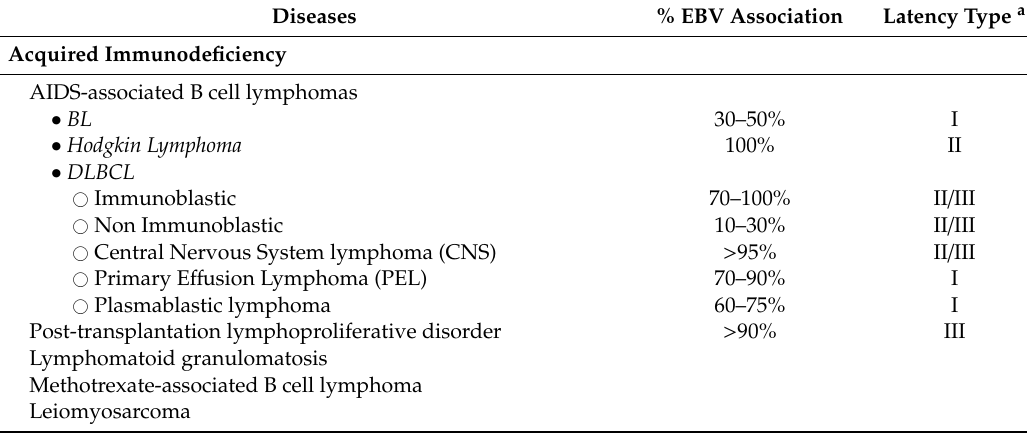
Table 2. EBV-associated malignancies in immunodeficient hosts and corresponding EBV association frequency and latent gene expression